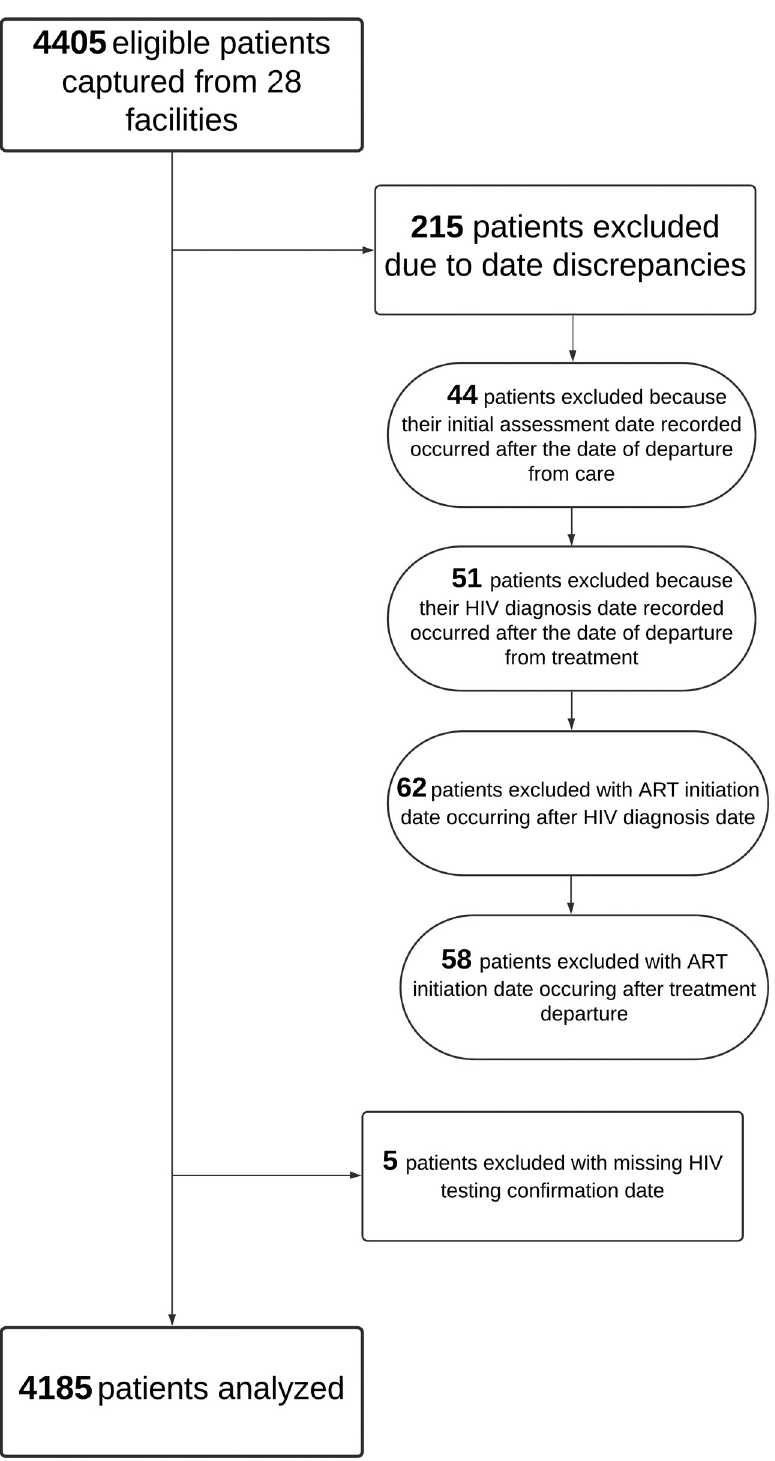
Fig 1. Flow diagram depicting the records of eligible patients reviewed and included in the analyses.